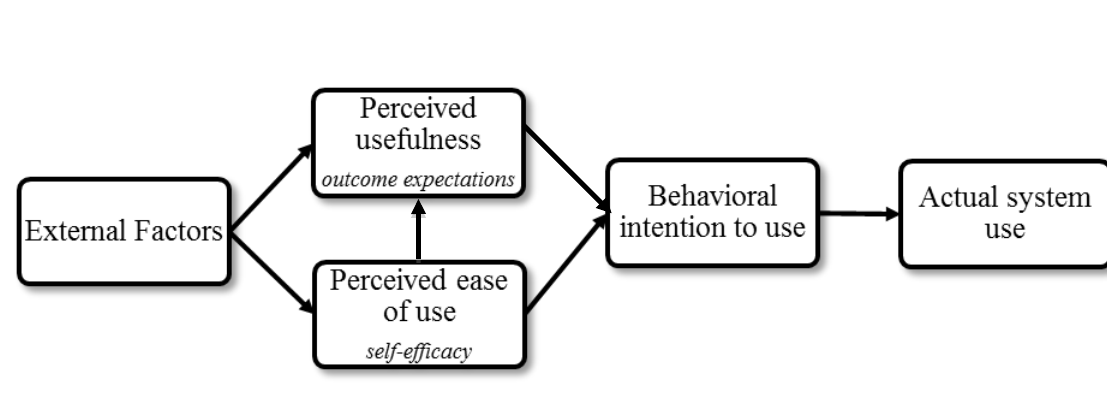
Figure 2. The technology acceptance model (Davis, 1989) with corresponding elements from Bandura (1989) in